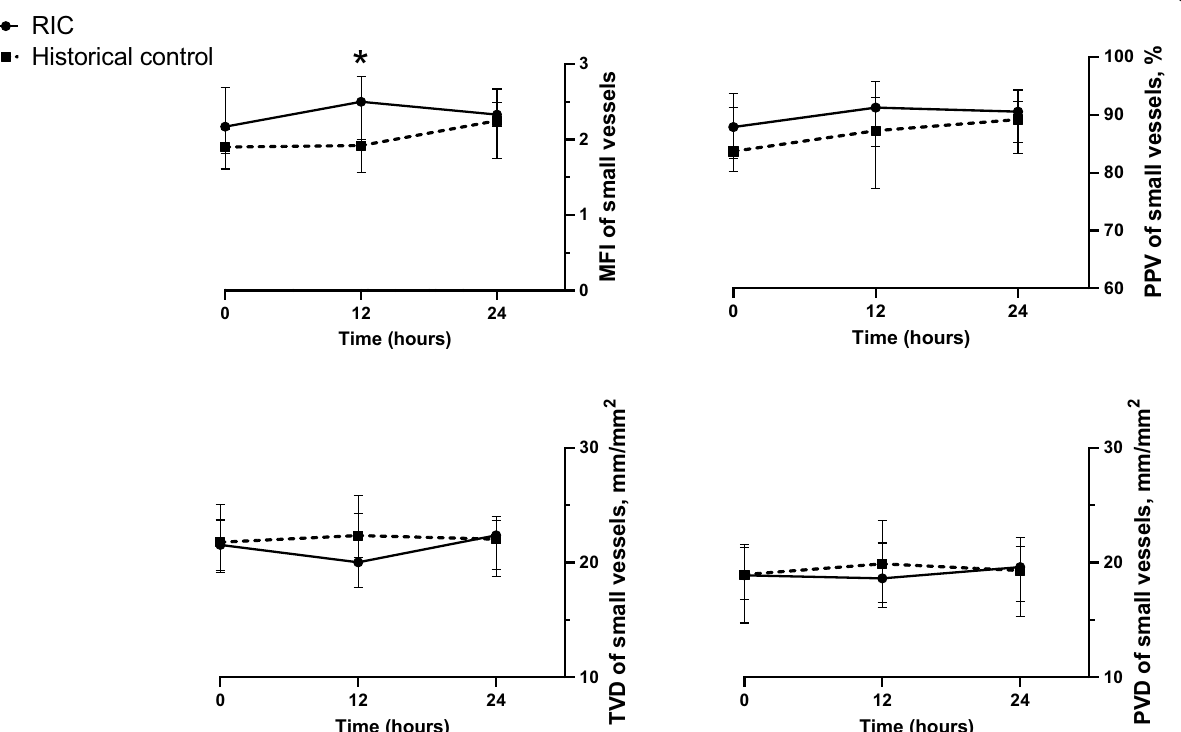
Fig. 3 Line and scatter plot showing the median (interquartile range) of microcirculatory parameters over 24 h in the RIC and historical control groups. MFI microvascular flow index, PPV proportion of perfused vessels, TVD total vessel density, PVD perfused vessel density. * p < 0.05 compared